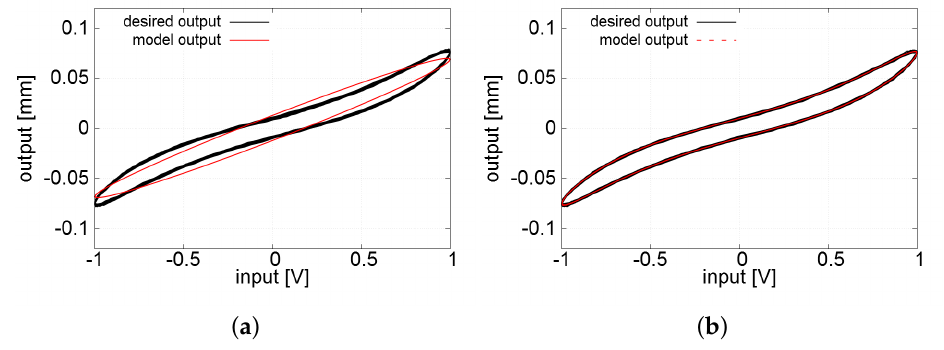
Figure 11. The model outputs and the measurement of the actuator displacement to the 23 Hz sinusoidal input. The proposed enhanced Bouc–Wen model (6) shows good accuracy, whereas the previous extended Bouc–Wen model fails to capture the twisted shape of the hysteresis loop. ( a ) Result with the extended Bouc–Wen model in [9]; ( b ) Result with the enhanced Bouc–Wen model